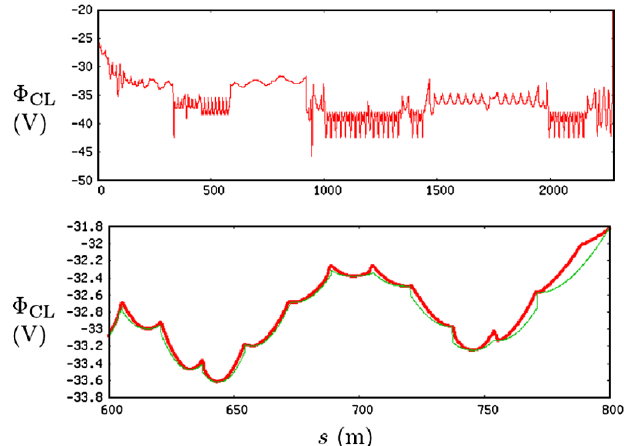
FIG. 7. (Color) Emittance increase while transversing the 100 m (thick-dark-red) and 200 m (thin-light-green) ion fields (hori- zontal axis in percent of distance L ).